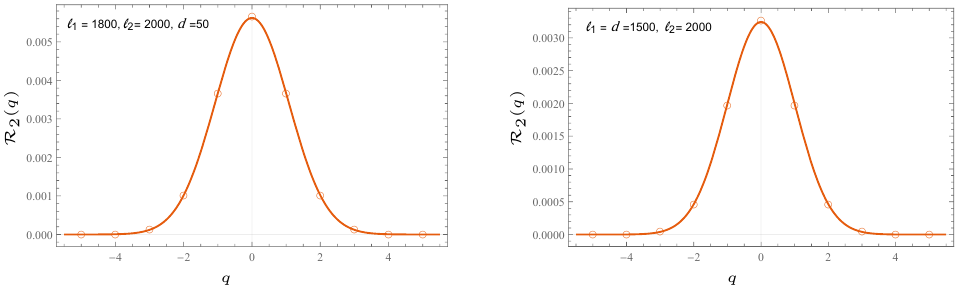
Figure 7 . Plots for charged imbalance resolved Rényi negativity for n = 2 . The continuous lines are plots of R 2 ( q ) from eq. (5.4) with K = 1 as a function of charge q . The discrete points are the plots of numerically evaluated charged imbalance resolved Rényi negativities for tight-binding model given by plugging eq. (C.6) in eq.